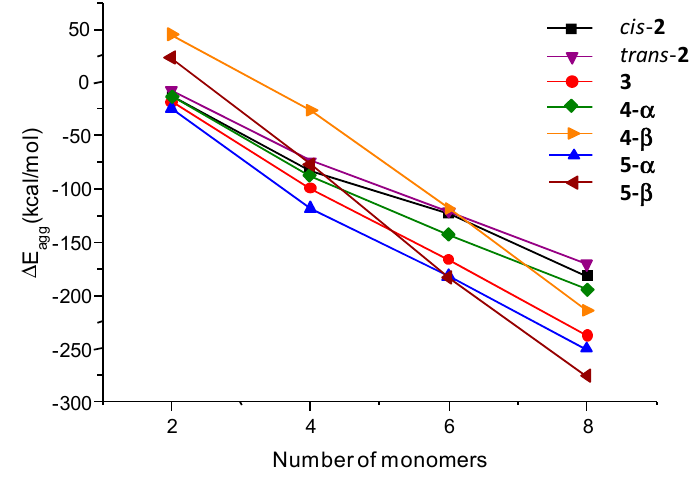
Figure 9. Aggregation energies of compounds 2 – 5 .